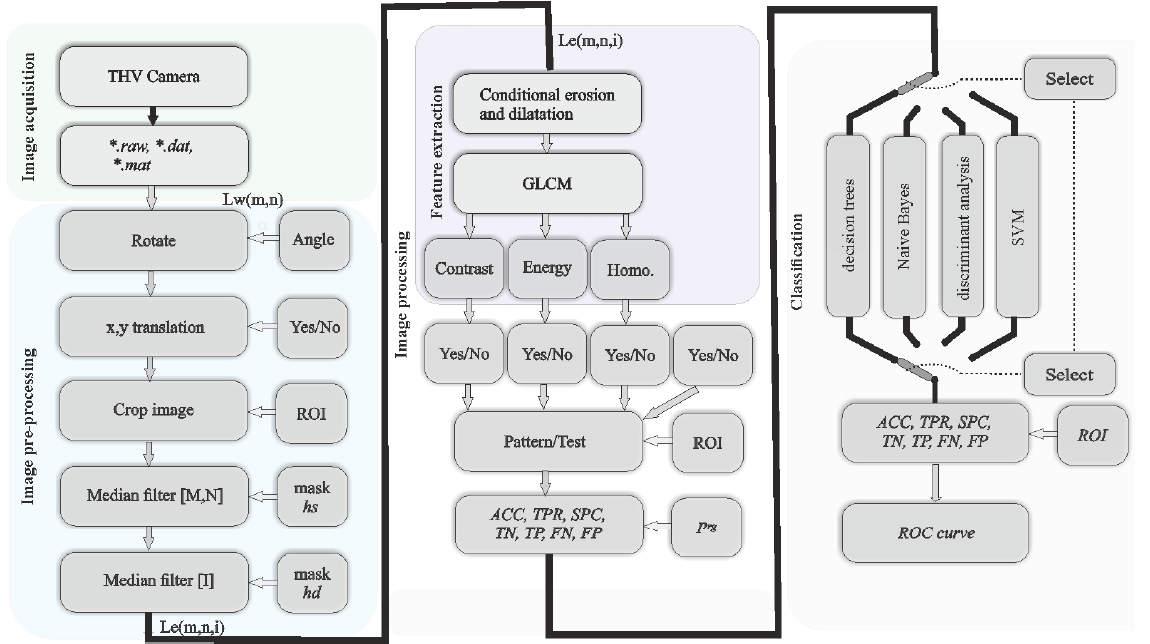
Figure 1. Block diagram of the image analysis and processing algorithm.